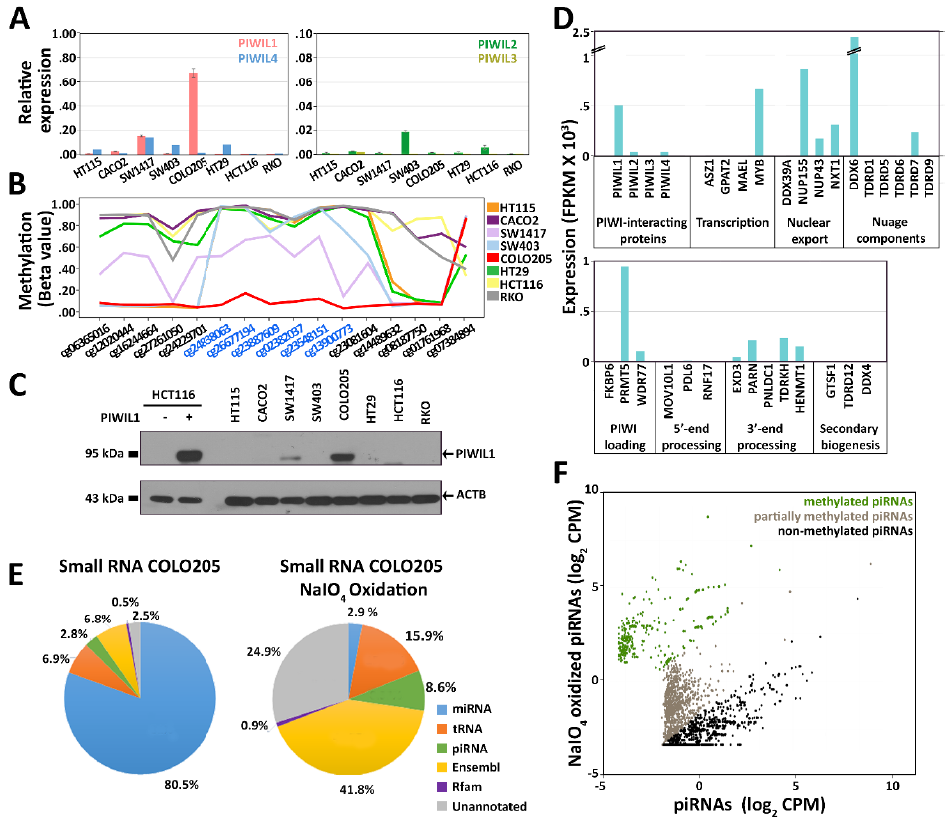
Figure 2. Characterization of main molecular features of the piRNA pathway in colorectal cancer (CRC) cell lines. ( A ) The expression level of PIWIL mRNAs in 8 CRC cell lines was determined by real-time qRT-PCR. The highest expression for PIWIL1 was observed in COLO 205 and SW-1417. PIWIL2 and PIWIL4 were identified in some cell lines but at lower levels, while PIWIL3 was undetectable in all cases. ( B ) DNA methylation profile of PIWIL1 promoter in 8 CRC cell lines; a marked hypomethylation, correlated to PIWIL1 expression, was observed for two cell lines (COLO 205 and SW-1417), while a strong methylation was present in the absence of PIWIL1 . CpG sites highlighted in blue constitute a CpG island. ( C ) Western blotting analysis performed onto total protein lysate from 8 CRC cell lines confirmed the presence of abundant PIWIL1 levels in COLO 205 and medium-abundant levels in SW-1417; as a control to test the specificity of the antibody, total protein lysate from HCT 116 cells overexpressing PIWIL1 or transfected with empty vector were loaded in the same gel; β -actin was used as a loading control. ( D ) Gene expression (indicated as fragment per kilobase million, FPKM) was measured for known germline components of the piRNA pathway genes by RNA-Seq; genes were grouped according to their role in the piRNA pathway. ( E ) Pie-chart representing the relative abundance of small RNA categories identified in non-treated (left) and sodium-periodate (NaIO 4 ) / β -elimination oxidized RNA (right) from COLO 205; small RNA-Seq analysis confirmed the presence of piRNAs in the COLO 205 cell line and their resistance to the sodium periodate / β -elimination treatment. ( F ) Scatterplot representing the e ff ect of the sodium periodate (NaIO 4 ) / β -elimination treatment on the piRNAs population; log 2 CPM (count per million) values are displayed per each COLO 205 piRNA in treated ( y -axis) and non-treated ( x -axis) RNA; the treated (T) vs. non-treated (NT) log 2 ratio of expression values ( p value < 0.01) was used to identify 767 methylated piRNAs (log 2 (T / NT) > 2), 1514 partially methylated piRNAs ( − 2 < log 2 (T / NT) < 2), and 2078 non-methylated piRNAs (log 2 (T / NT) < − 2) show that PIWIL1 transcripts were highly abundant in COLO 205 and medium-low expressed in SW-1417 cell lines, while PIWIL2 and PIWIL4 genes were expressed at low levels in 6 out of 8 cell lines and PIWIL3 was undetectable in all cases with HCT 116 and RKO cells negative for all PIWIL